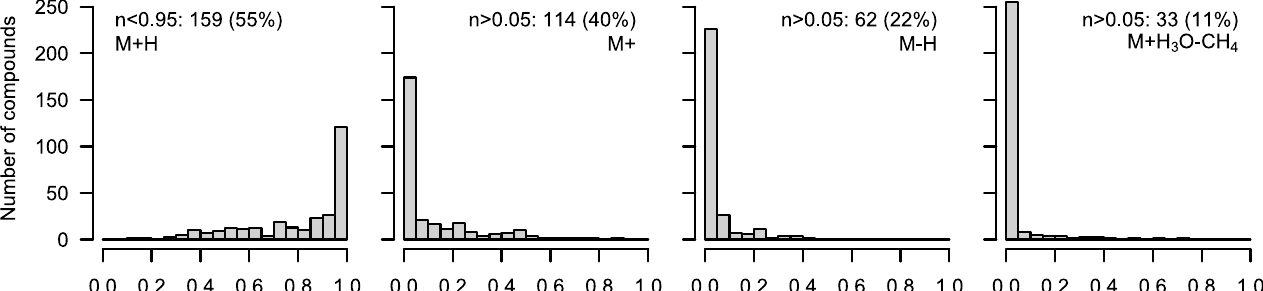
Figure 3. Occurrence of different fragments in 288 standard compounds of the library, which were estimated to have 100% M0 (only naturally abundant 13 C). A nearly exclusive formation of [M+H] + was found in 129 compounds, while in 159 compounds, other fragments made up >5% of the total frequency. Proton losses in significant amounts occurred more often ([M] + = 114, [M-H] + = 62) than the formation of [M+H 3 O − CH 4 ] + (33).